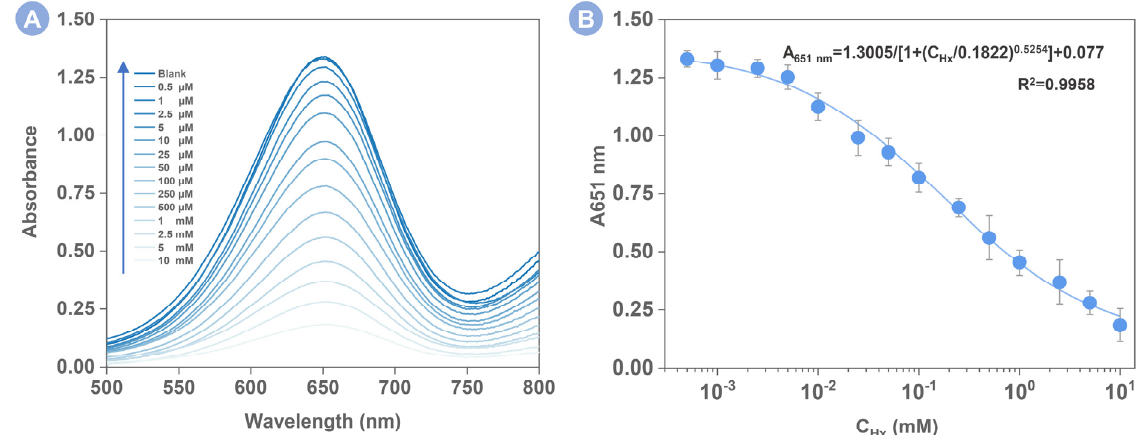
Figure 5. ( A ) Typical UV–vis spectra collected from the PVP-PtNC-based sensing system introduced with Hx at a concentration range from top to bottom: 0, 0.5 μ M, 1.0 μ M, 2.5 μ M, 5.0 μ M, 10 μ M, 25 μ M, 50 μ M, 100 μ M, 250 μ M, 500 μ M, 1 mM, 2.5 mM, 5 mM, 1 mM, and 10 mM. ( B ) The dynamic relationship of the peak absorption intensity against the Hx concentration. Error bars were obtained from three repetitive experiments.